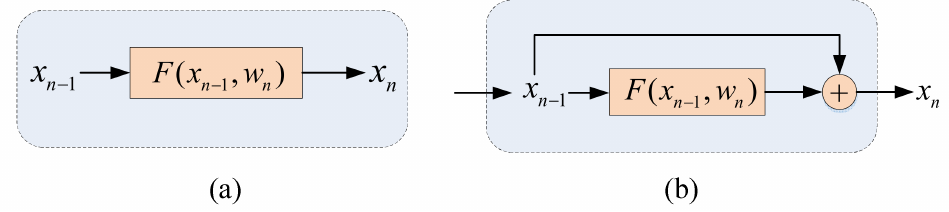
Figure 4. ( a ) The traditional convolutional neural network. ( b ) Residual